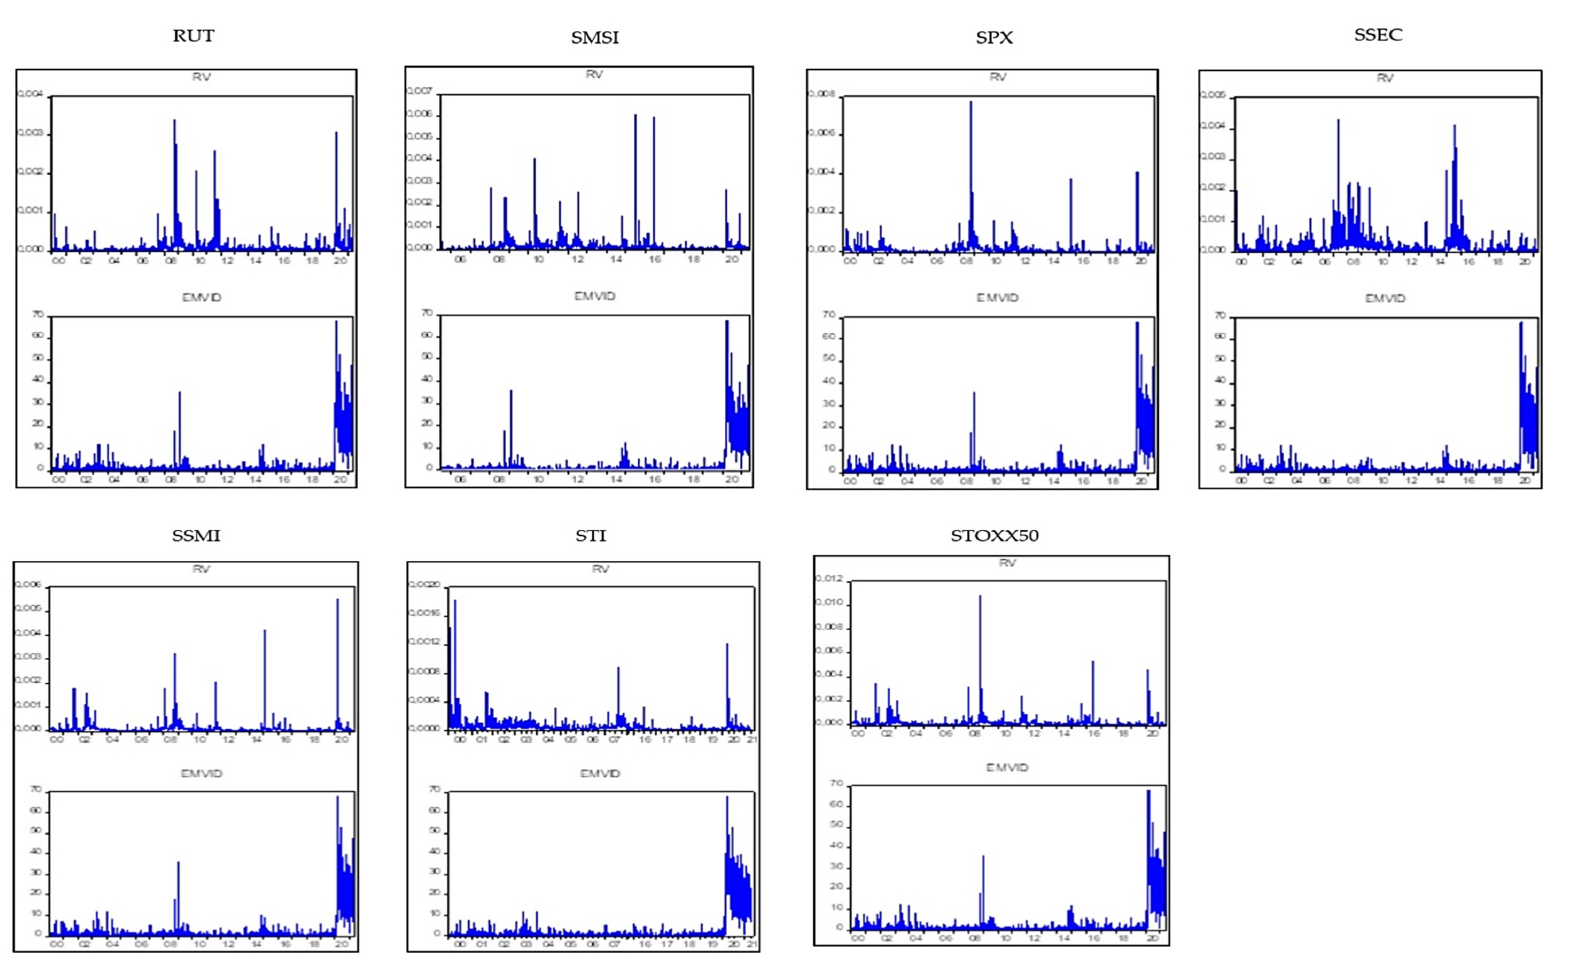
Figure A1. Data Plots. Note: RV is the realized volatility estimates for international stock markets index: EMVID is the newspaper-based uncertainty index due to infectious diseases. * indicates stock markets shocks because of infectious diseases.